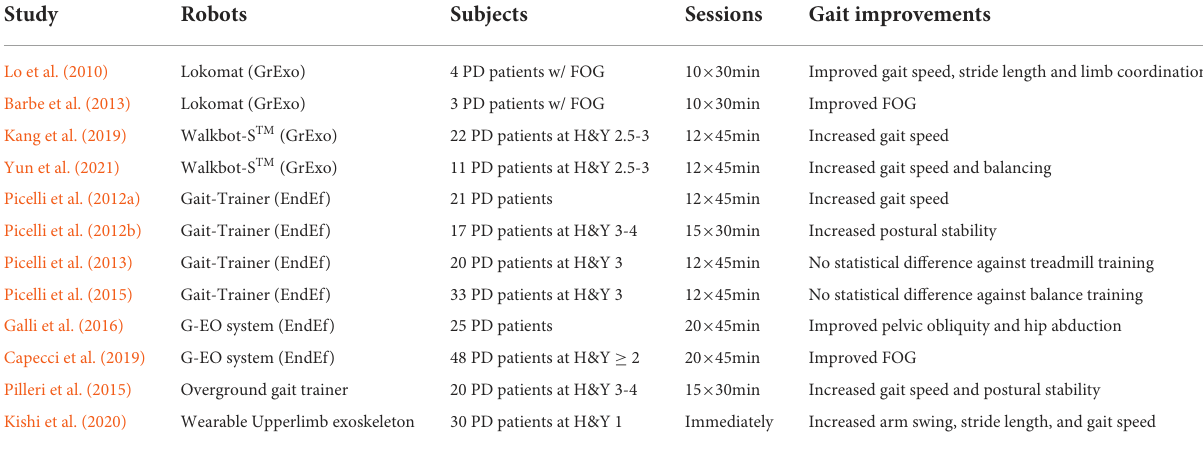
TABLE 8 Summary of robot-assist gait training on PD